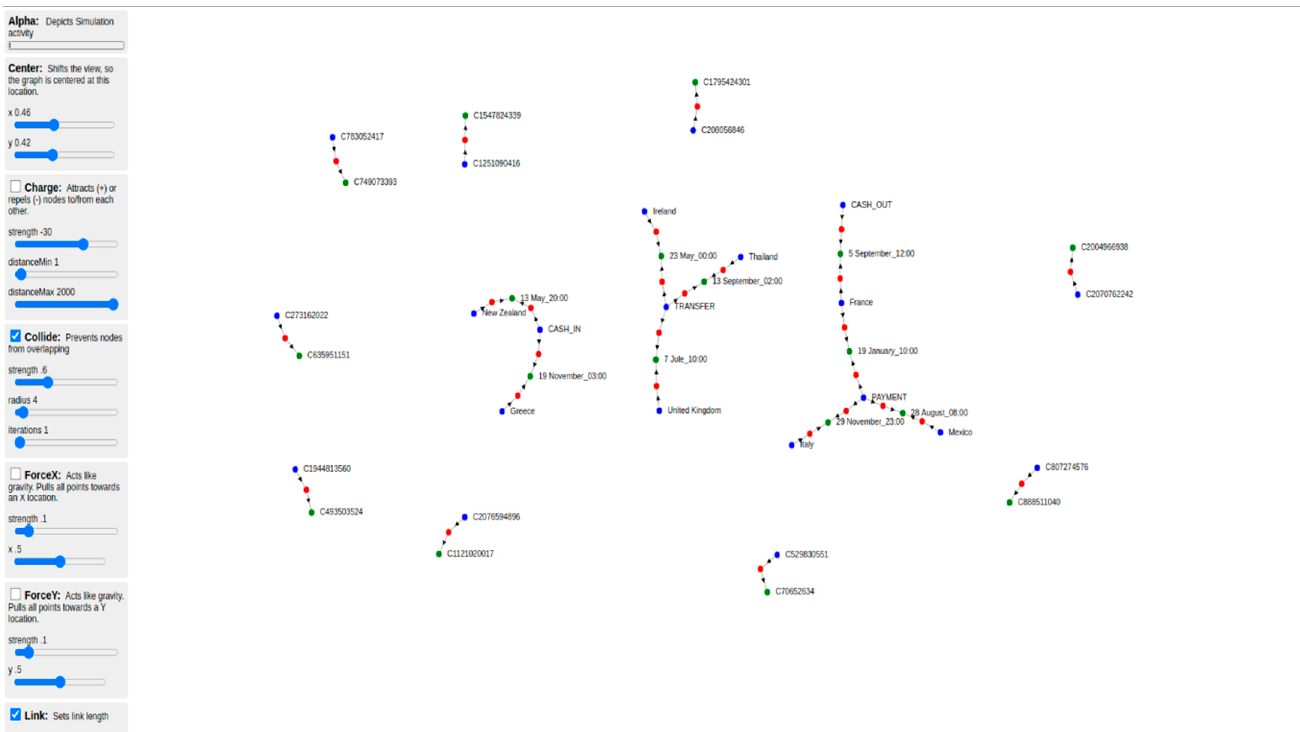
Figure 6. Knowledge graph visualization tool User Interface (UI).